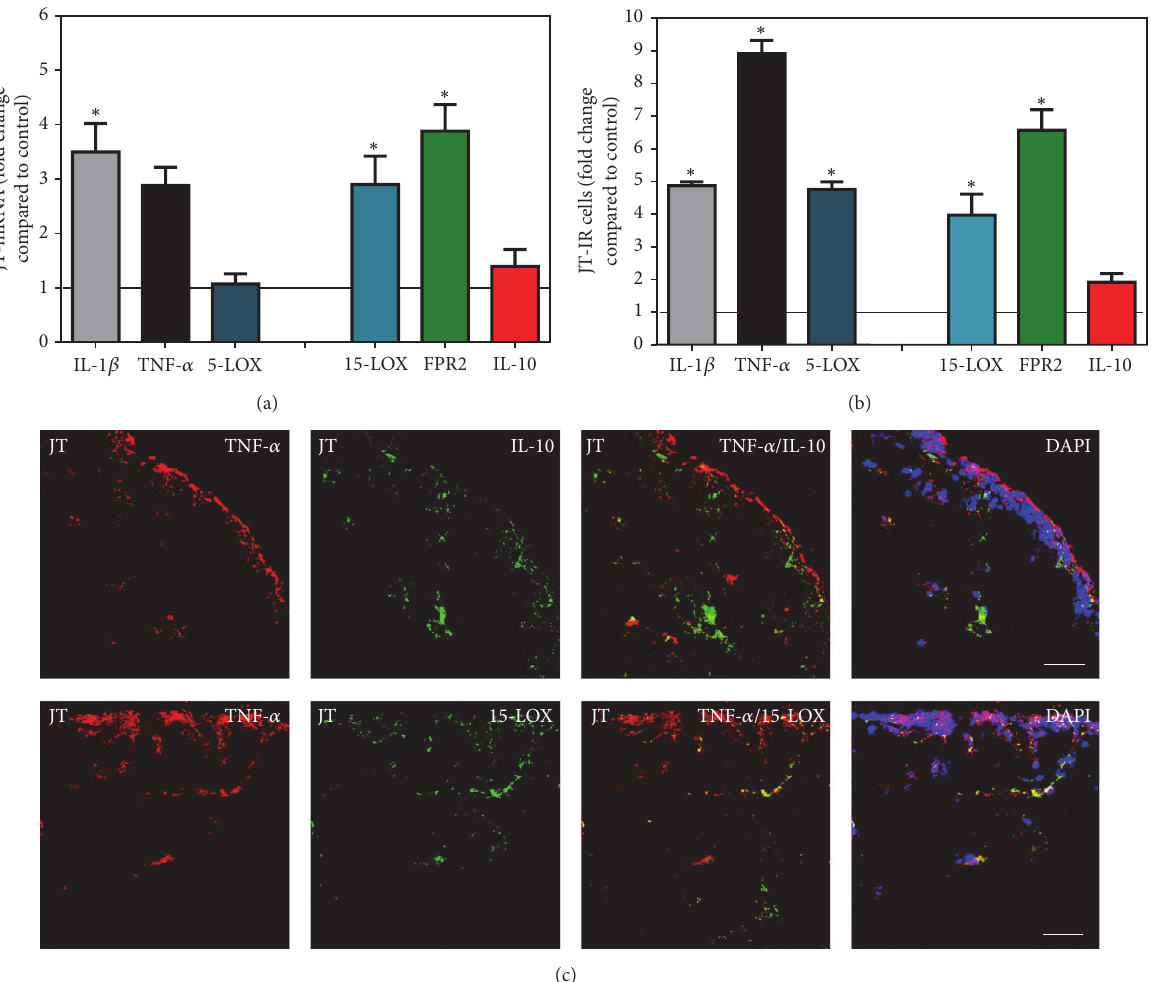
Figure 5: Detection of mRNA (a) and the number of positive cells of inflammatory (IL-1 𝛽 , TNF- 𝛼 , and 5-LOX) versus anti-inflammatory (15- LOX, FPR2, and IL-10) mediators (b and c) in patients with joint trauma (JT). (a) Quantification of mRNA of pro- versus anti-inflammatory mediators shows that there is a balance between expressions of pro- versus anti-inflammatory mediators in JT synovium. (b) Quantitative analysis of immunofluorescence microscopy of pro- versus anti-inflammatory mediators shows that the number of cells expressing anti- inflammatory mediators was comparable with those containing proinflammatory mediators in JT synovium. Data are shown as means ± SEM. ∗ Relative to control ( 𝑃 < 0.05 , one-way ANOVA followed by Tukey’s test). (c) Confocal microscopy of pro- ( red fluorescence ; (a), (b)) andanti-inflammatorymediators( greenfluorescence ;(c),(d))doubleimmunofluorescence(e–h)inJTsynovium.Notethatanti-inflammatory mediator expression was comparable with those containing inflammatory mediators in JT synovium. Bar = 40 𝜇